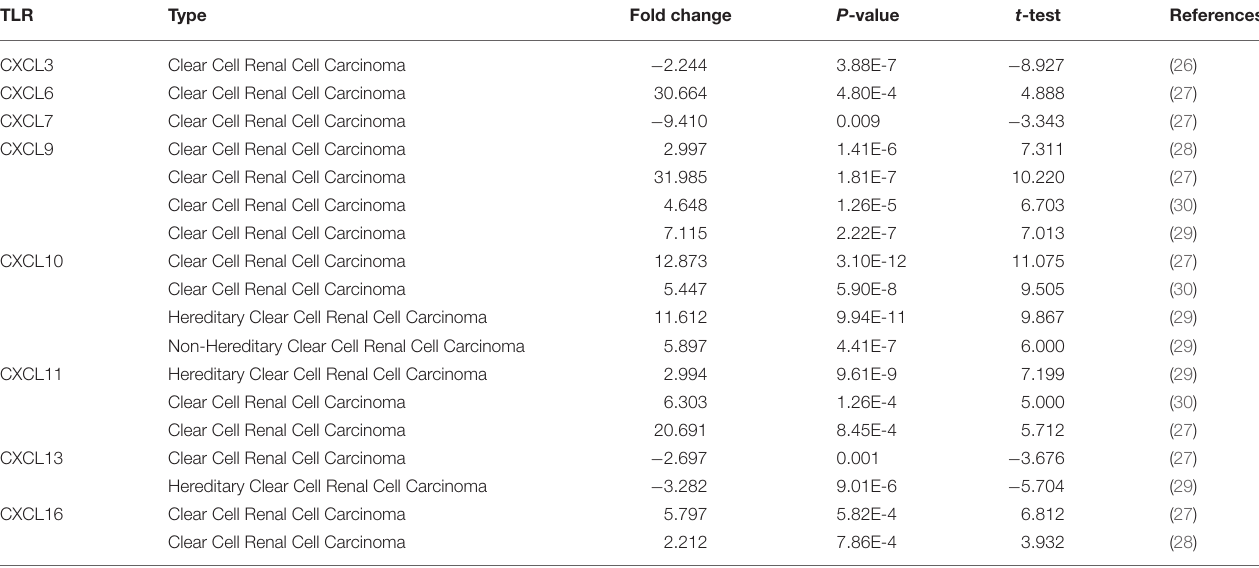
TABLE 1 | The mRNA levels of CXC chemokines in different types of RCC tissues and normal renal tissues at transcriptome level (ONCOMINE). TLR Type Fold change P -value t